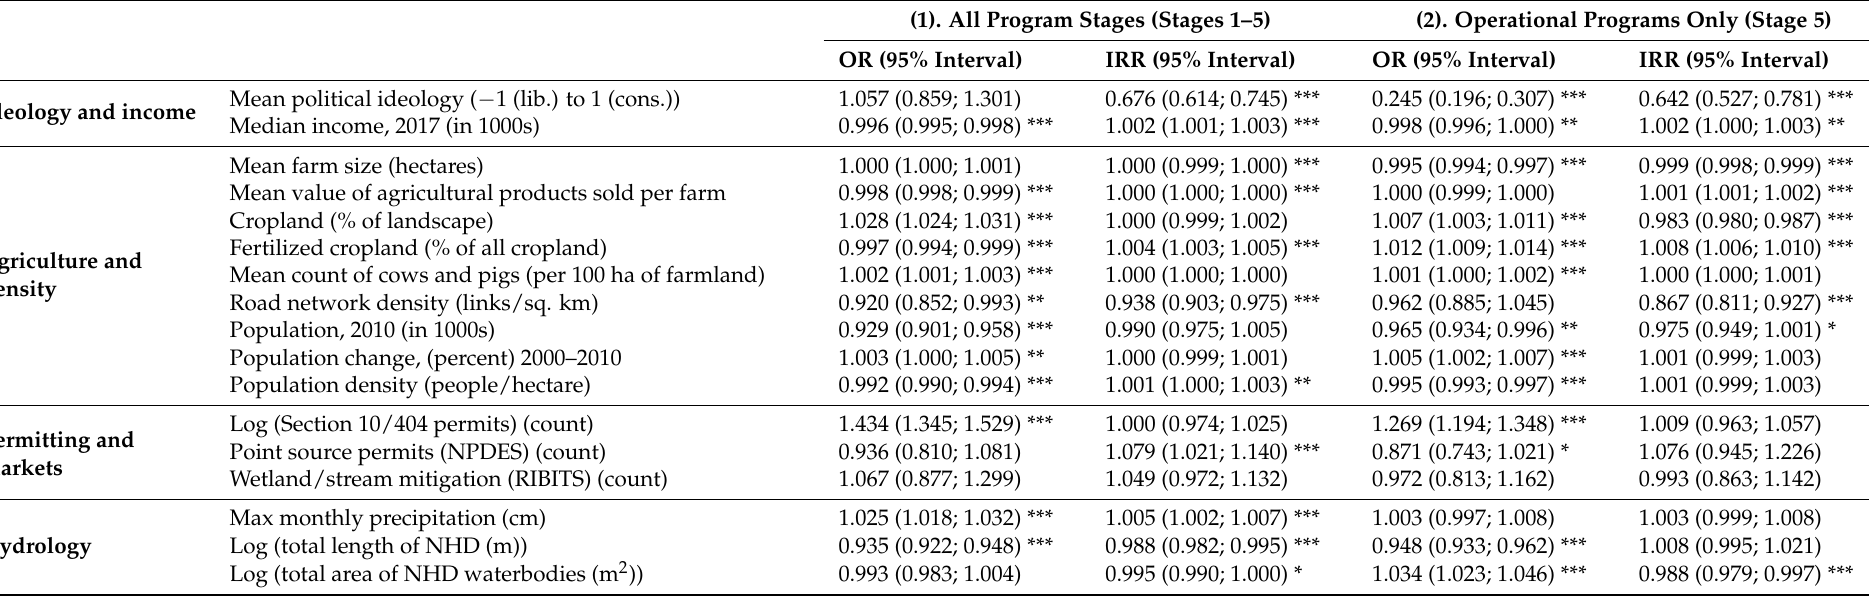
Table A1. Hurdle regression model results showing sensitivity analysis whereby tracts include water quality trading (WQT) program if there is more than 25% areal overlap with program (instead of a 50% overlap as given in Table 3 of main text). Hurdle model predictions of existence and abundance of (1) operational and nonoperational water quality trading programs (all Stages 1–5) and (2) operational water quality trading programs (Stage 5 only). Depicts effects on odds ratios (OR) for binary logistic regressions and on incident rate ratios (IRR) for truncated negative binomial regressions, with 95% confidence intervals for each. Hydrologic variables, except precipitation, are summarized to the tract level (see Appendix C for discussion). n = 6940 tracts for all. * p < 0.1; ** p < 0.05; *** p <